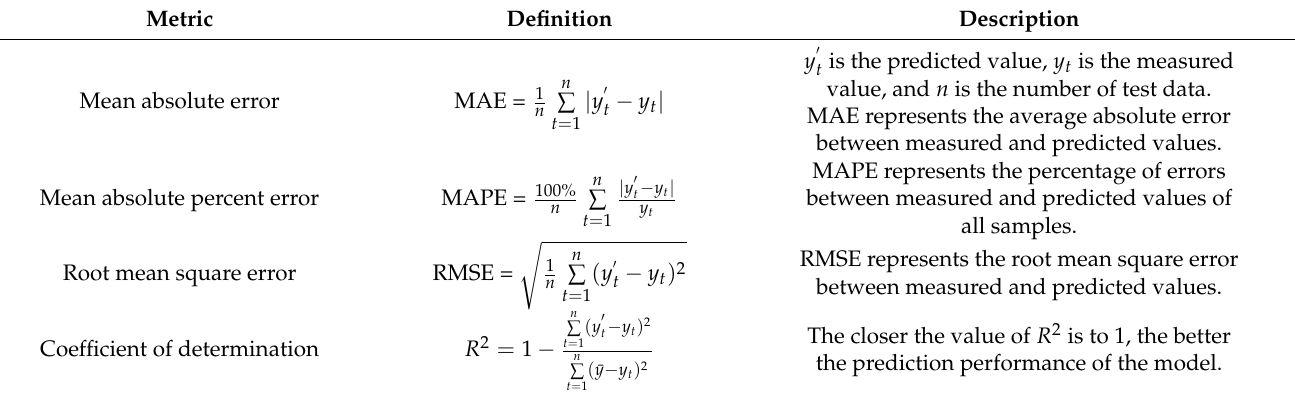
Table 3. Metrics of the prediction performance.